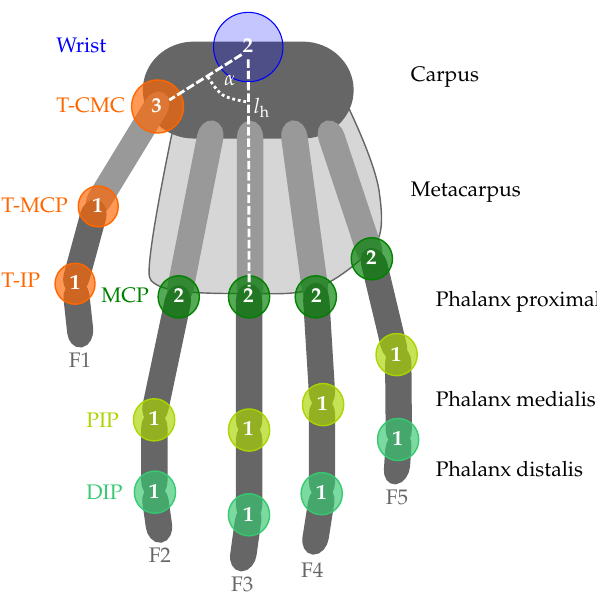
Figure 3. Modeled bones and joints of the human hand. The fingers are numbered from F1 (thumb) to F5 (little finger). The modeled joints are illustrated as colored circles with numbers indicating the considered degrees of freedom of the joint. The metacarpals (light gray) of F2–F5 form the palm, which is treated as flat and rigid. The white dotted line from the wrist to the MCP joint of the middle finger marks the length of the palm l h , which needs to be measured for the model. The remaining joint center positions of MCP and T-CMC are deviated via constant ratios and angles, as exemplarily shown for the thumb with angle α = 58°.